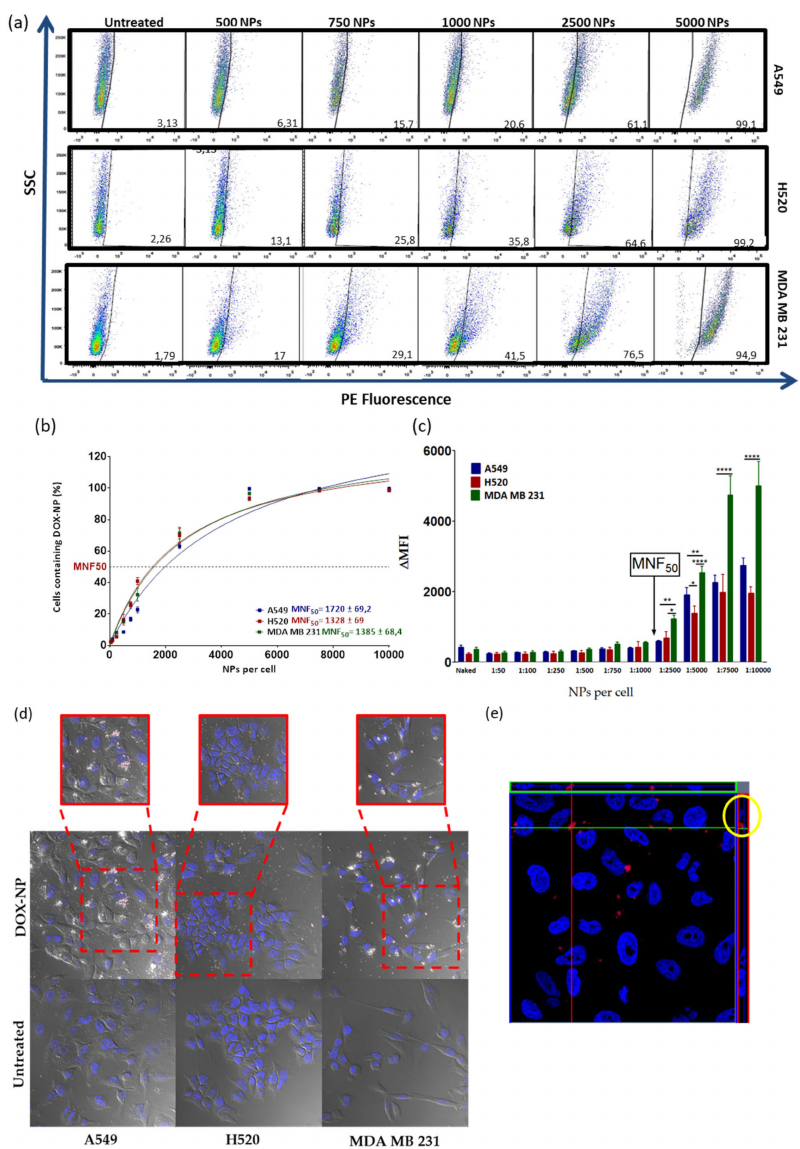
Figure 2. Evaluation of the cellular nanofection of DOX-NPs ( 7 ) in the cell lines A549, H520, and MDA MB 231 by flow cytometry. ( a ) Dot plots representative of flow cytometry obtained by incubating di ff erent concentrations of NPs for 24 h in the cell lines. ( b ) Percentage of cells containing the di ff erent concentrations of DOX-NPs ( 7 ). The data (mean ± SEM) are represented with a hyperbola equation model showing the di ff erent degrees of cellular internalization according to the number of DOX-NPs ( 7 ). ( c ) Representation of bars to compare ∆ MFI between cell lines: A549 (blue), H520 (red), and MDA MB 231 (green). The arrow indicates the MNF50. The experiments were carried out in triplicate and the results are expressed with the values of the mean ± SEM. The statistical significance was determined by the analysis of the variance of a factor (ANOVA) using the Bonferroni multiple comparison (* p -value < 0.05, ** p -value < 0.001, **** p -value < 0.0001). MNF50: Multiplicity of nanofection 50. ( d ) Evaluation of uptake cellular of DOX-NPs ( 7 ) in the cell lines analyzed by confocal microscopy. The cells were incubated for 24 h with 2000 NPs / cell. The untreated cells were used as a negative control. Images with an increase of 63 × show a composition of the three channels used: DIC; blue, DAPI for the nucleus; and red for DOX-NPs ( 7 ). ( e ) Orthogonal view (xy, xz, and yz) of the confocal microscope images showing the intersection planes at the position of the cross-line. Maximum intensity projection of the z-stack from blue (DAPI, nuclei) and red (DOX-NPs ( 7 )) in the A549 cell line is